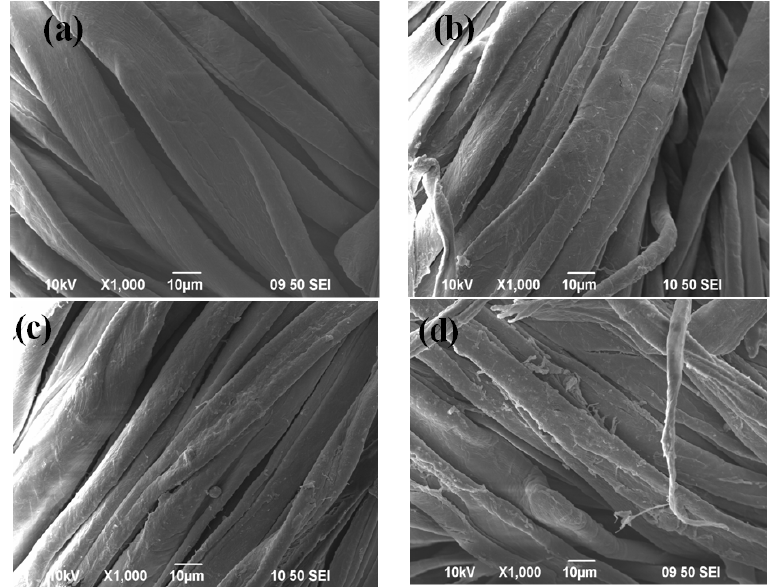
Figure 12. SEM Images of ( a ) pure cotton fabric, ( b ) TiO 2 coated cotton fabric, ( c ) dye/TiO 2 coated cotton fabric and ( d ) dye/TiO 2 coated cotton fabric with high concentration of RB ‐ 25.